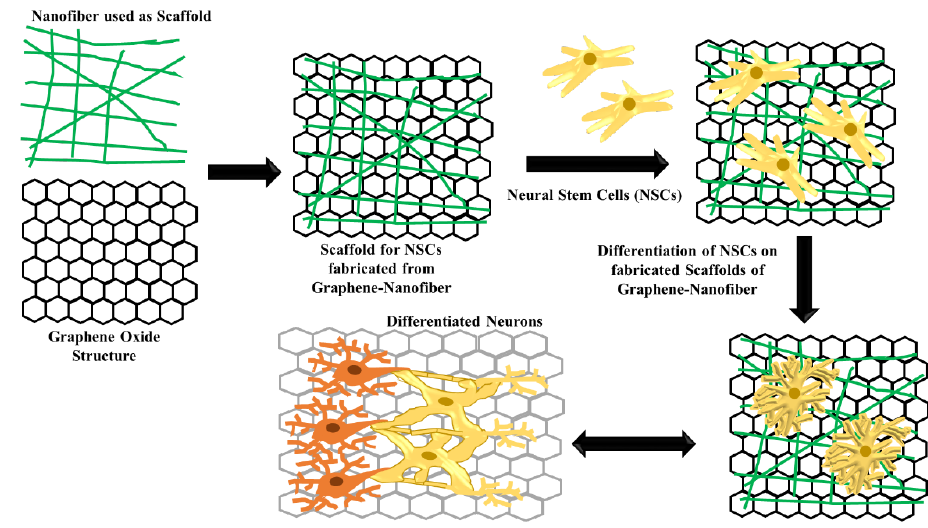
Figure 3. Schematic representative of scaffold structure fabricated from graphene – nanofiber for differentiation of neural stem cells.